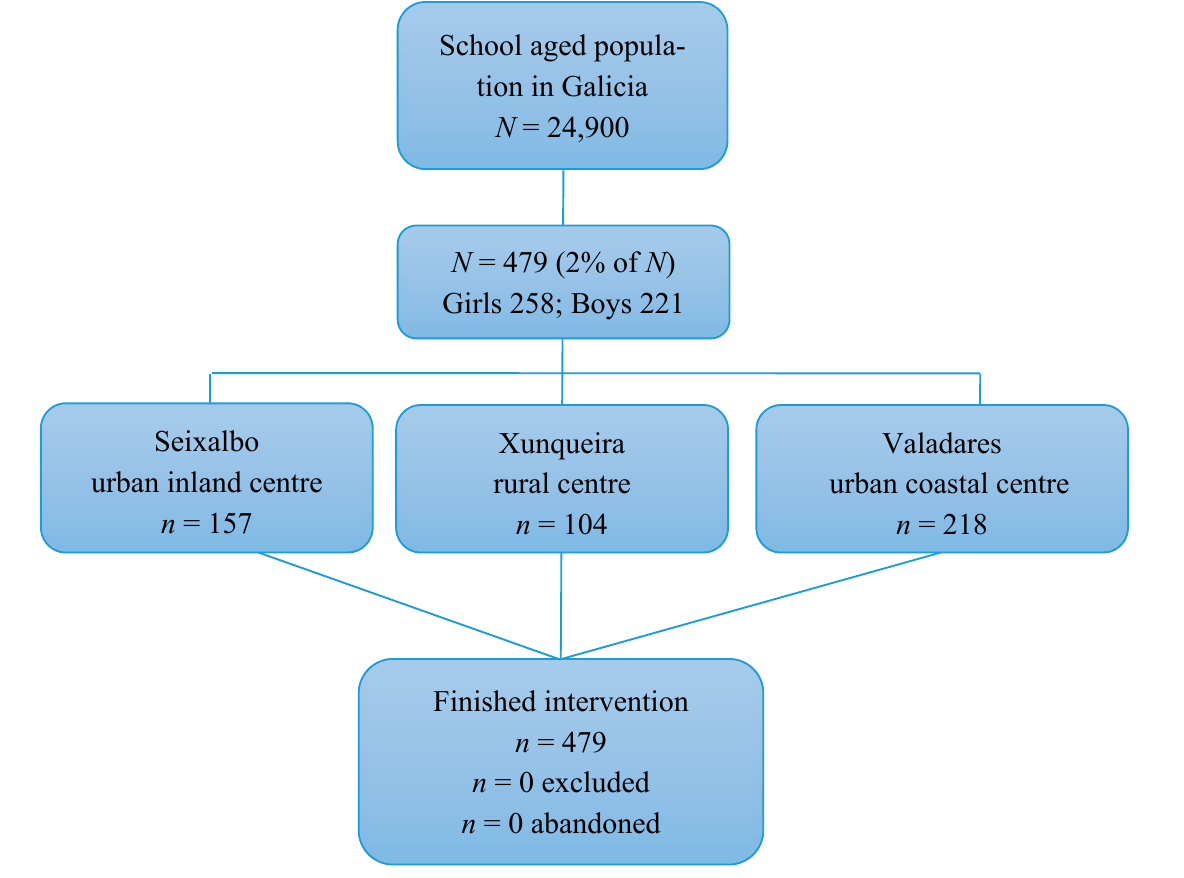
Figure 2. Flow diagram of the study sample. Table 1. Descriptive analysis of